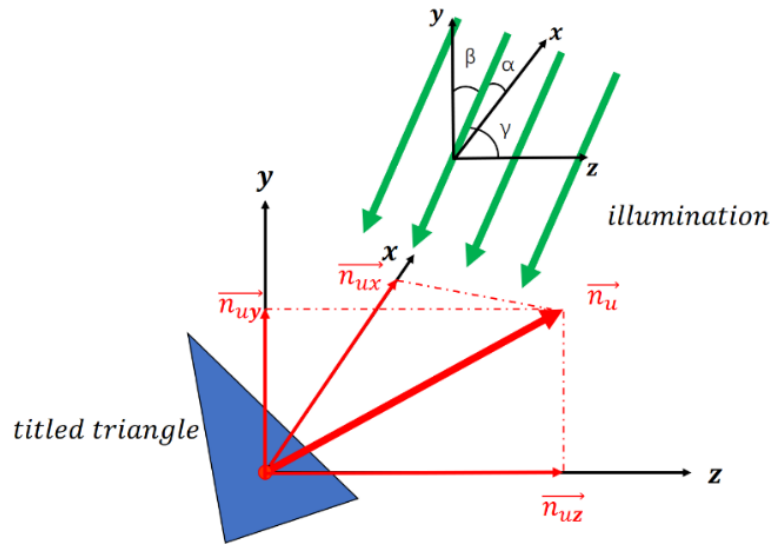
Figure 6. Principle of flat shading.